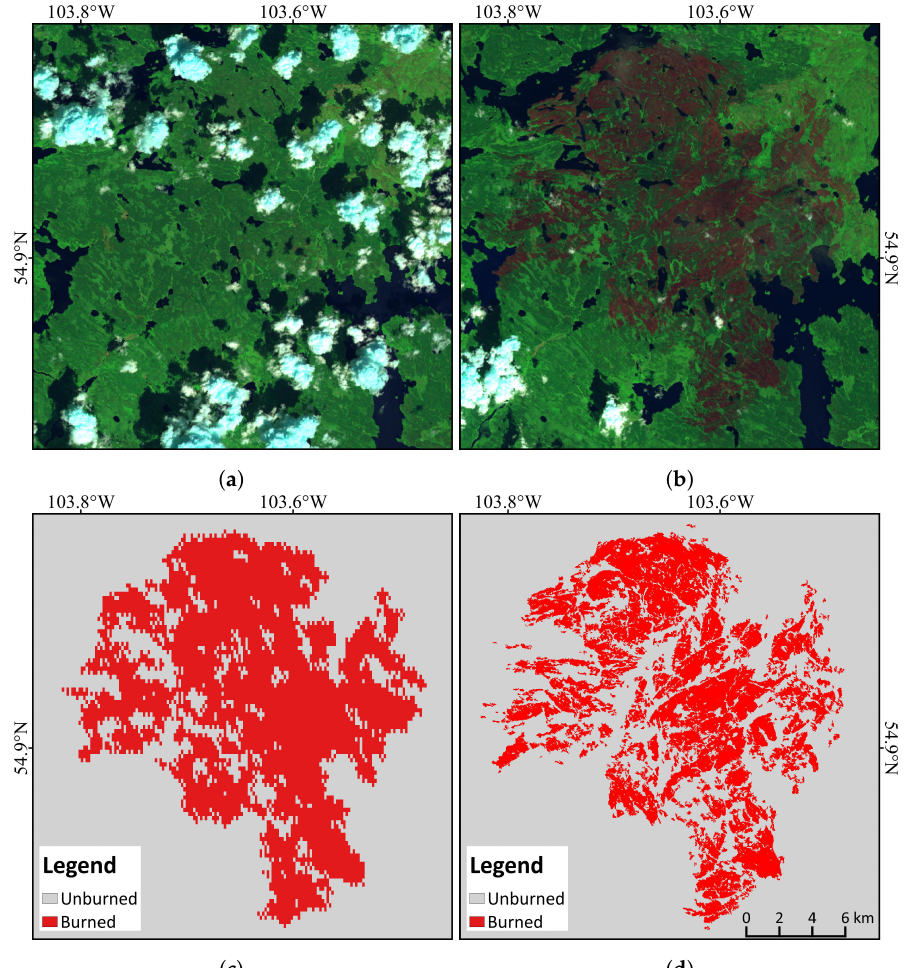
Figure 7. Comparison between Fire_cci and GABAM in Saskatchewan, Canada. ( a , b ) are the Landsat-8 images before (24 June 2015) and after (26 July 2015) fire, respectively, displayed in false color composition (red: SWIR2 band, green: NIR band, and blue: green band); ( c ) shows the burned areas of the annually-composited Fire_cci product, and ( d ) shows the burned areas generated by the proposed